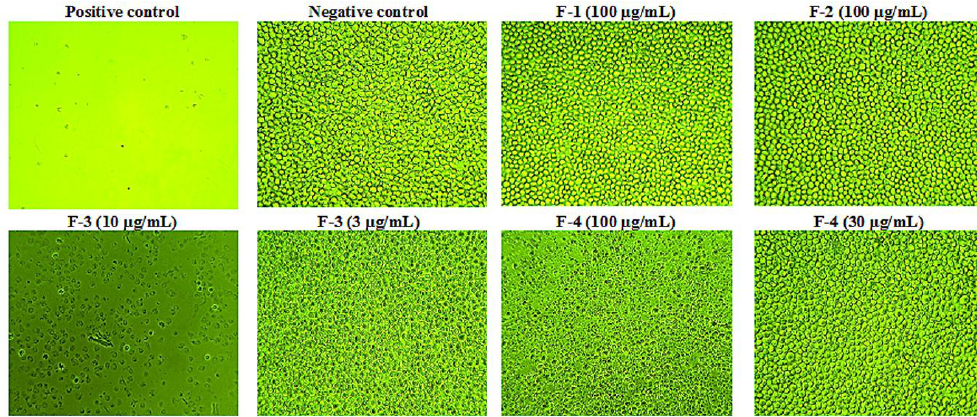
Figure 2. Cytotoxic effects of bee venom fractions on U937 cells. Fractions F-1 and F-2 were non-cytotoxic at the highest concentration of 100 µg/mL used, while F-3 was the most cytotoxic on the cells, as necrotic effects were observed even at 10 μg/mL (IC 50 5.4 µg/mL). On the other hand, F-4 was cytotoxic above 30 μg/mL with an IC 50 of 68.8 μg/mL ( n = 3). (Magnification = ×100).